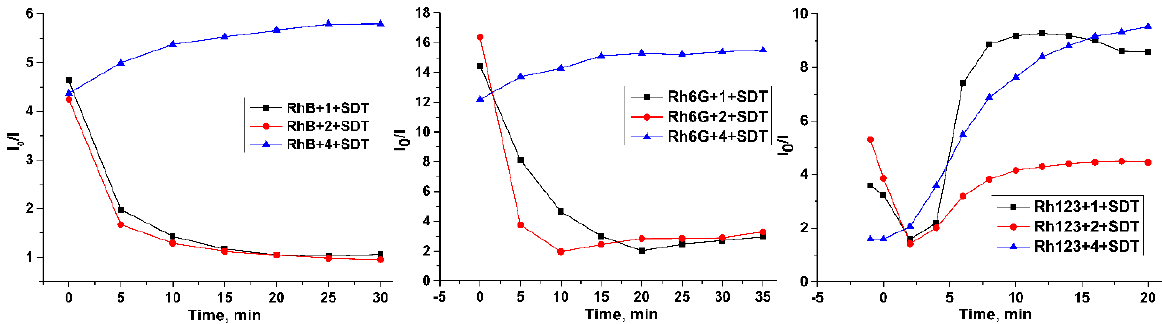
Figure 8. I 0 /I vs. time for rhodamine dye-calixarene systems in the presence of SDT. C (dye) = 1 μ M, C ( 1 , 2 , 4 ) = 1 μ M, C (SDT) = 100 μ M, PBS buffer (pH 7.4).